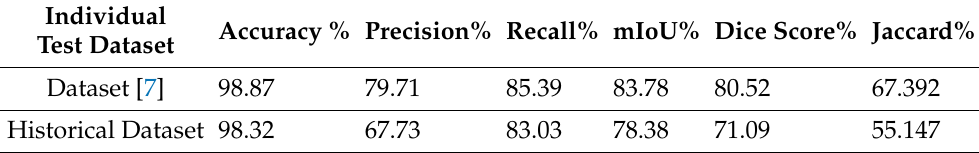
Table 7. Results of U 2 -Net-based crack segmentation on individual datasets.